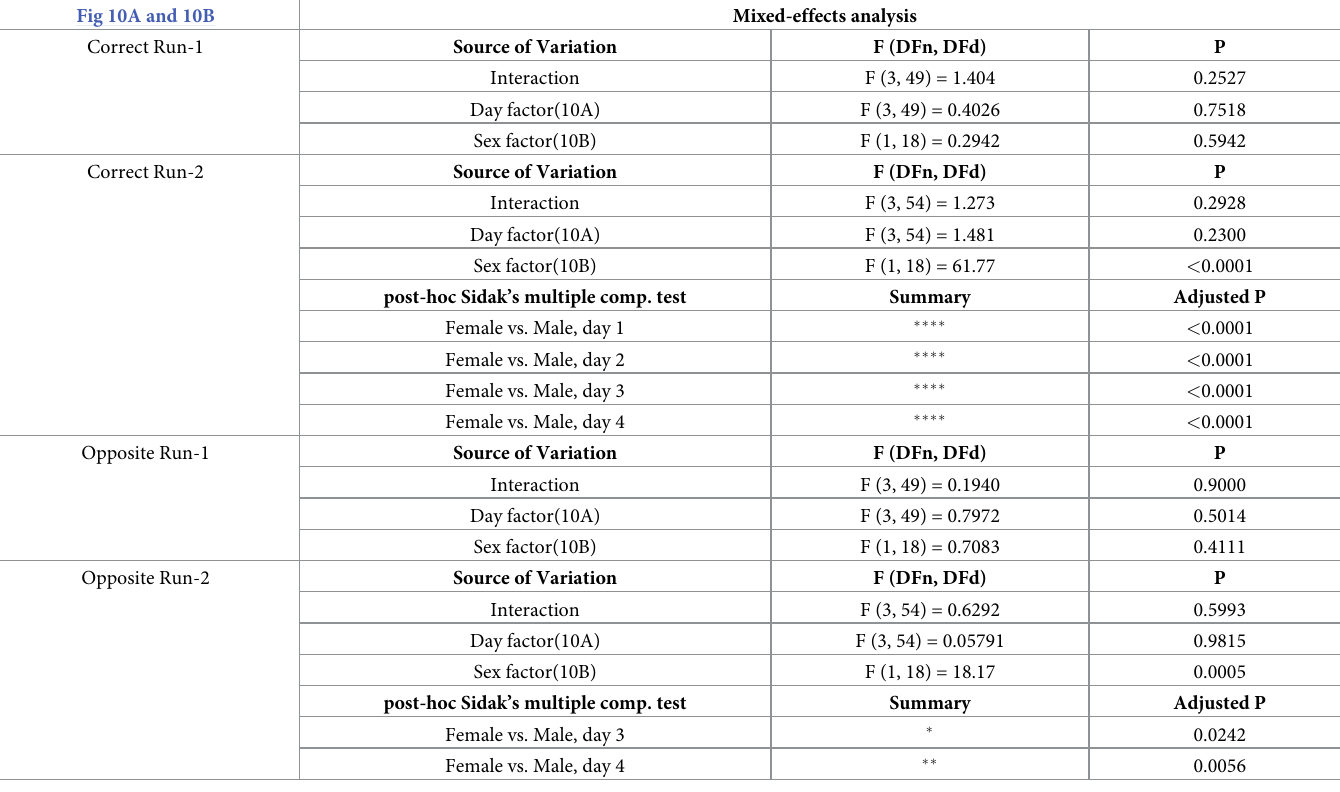
Table 16. Statistical analysis of data shown in Fig 10A and 10B for serial reversal, cohort B, Run-1, and Run-2. Fig 10A and 10B